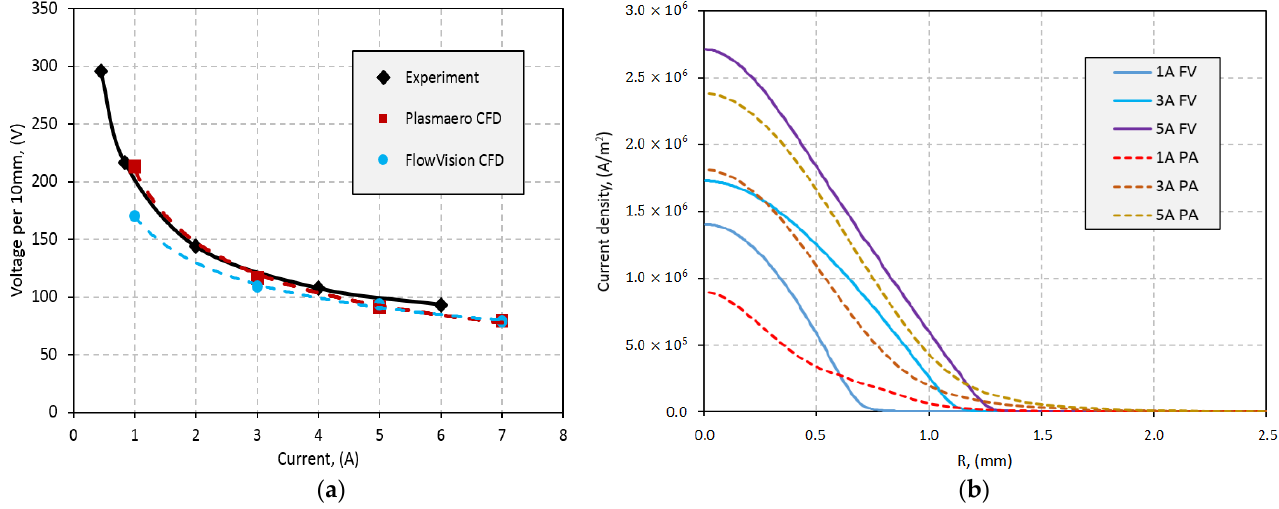
Figure 6. Voltage – current dependency ( a ) and comparison of current density profiles at x = 15 mm for FlowVision and Plasmaero at 1, 3, and 5 A ( b ).